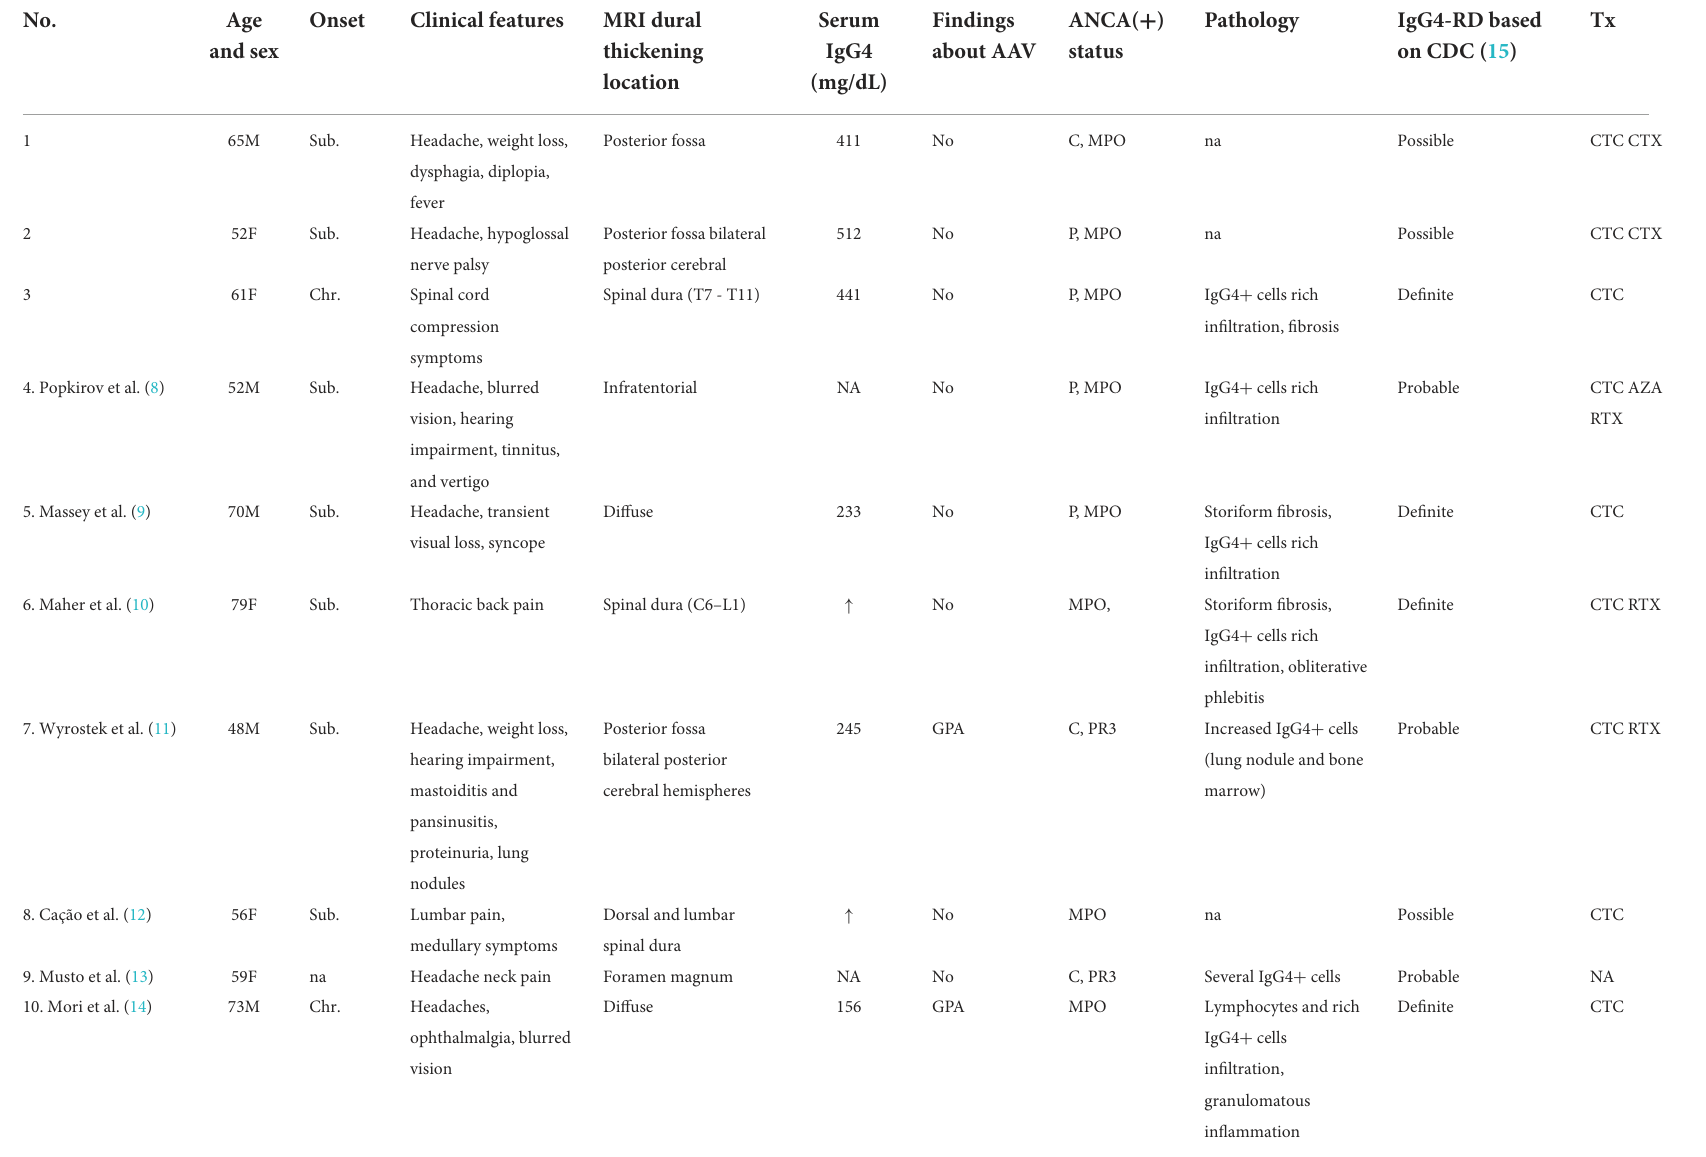
TABLE 1 Clinical, radiological, and laboratorial features of the patients.